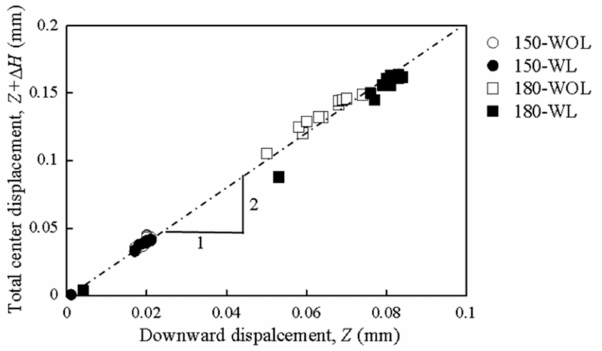
Figure 14. Relationship between the total center displacement and downward displacement. (150 / 180—Forging load (kN), WL—With Lubrication, WOL—Without